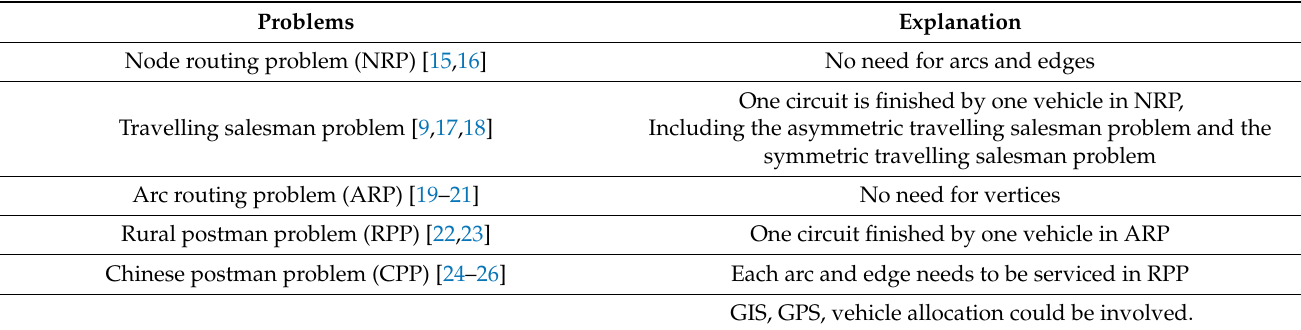
Table 1. Typical Vehicle Routing